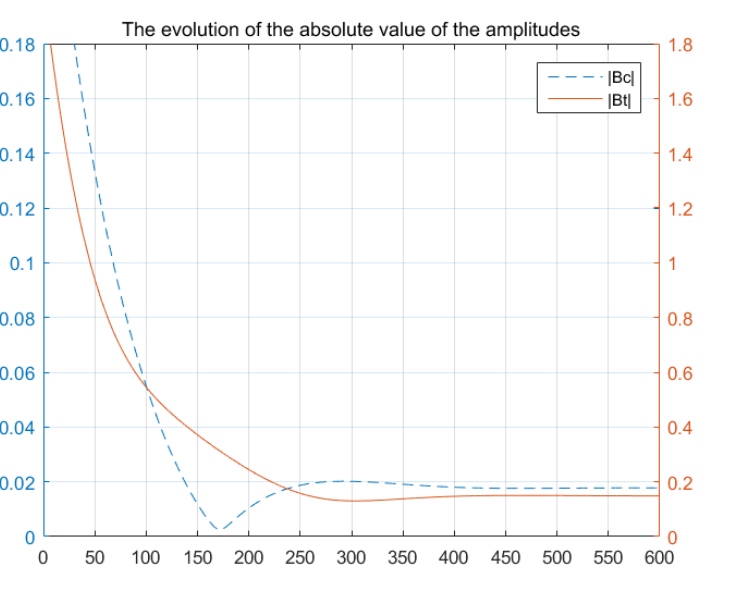
Figure 3. The calculations are performed for µ = 0.015, F = β = 20, H = 0.05, and k = l = π